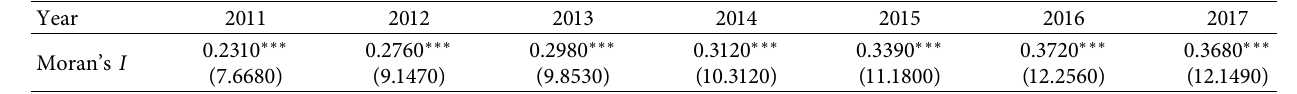
Table 3: Results of Moran’s I test for the regional innovation quality.